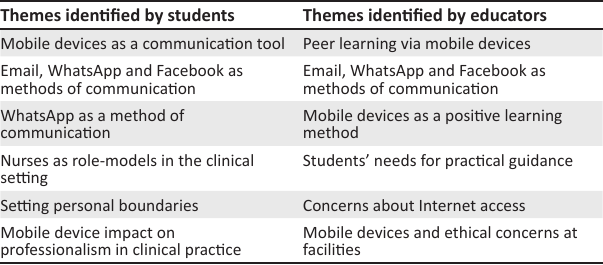
TABLE 2: Themes identified. Themes identified by